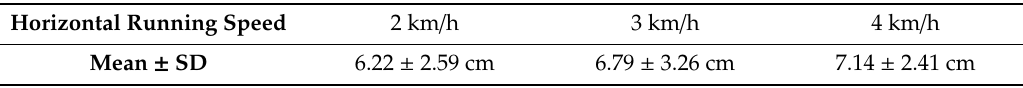
Table 5. E ff ect of UAV running speed on landing accuracy (simulation times n = 15 times). Horizontal Running